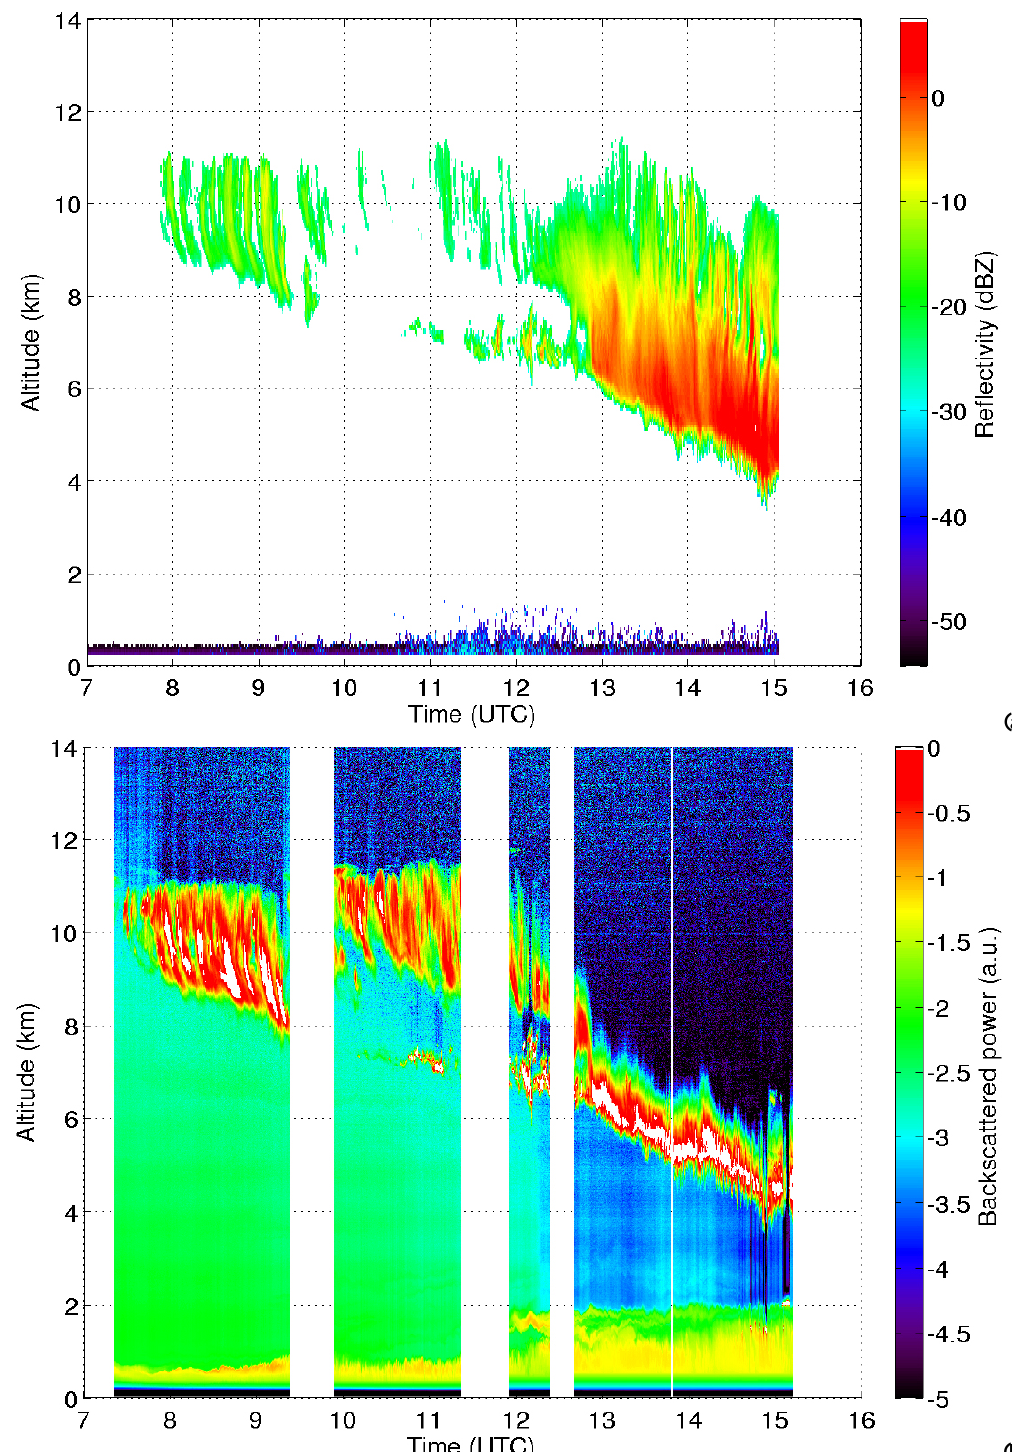
Fig. 4. Cloud layers observed at SIRTA on 1 April 2003. Vertical cross sections of (a) RASTA cloud radar reflectivity (dBZ), (b) LNA lidar backscattered power (proportional to m − 1 sr − 1 ), (c) cloud mask derived from radar-lidar synergies (green: radar only; yellow: lidar only; red: radar+lidar retrieval; grey: discrepancy between lidar and radar retrieval; other: no cloud